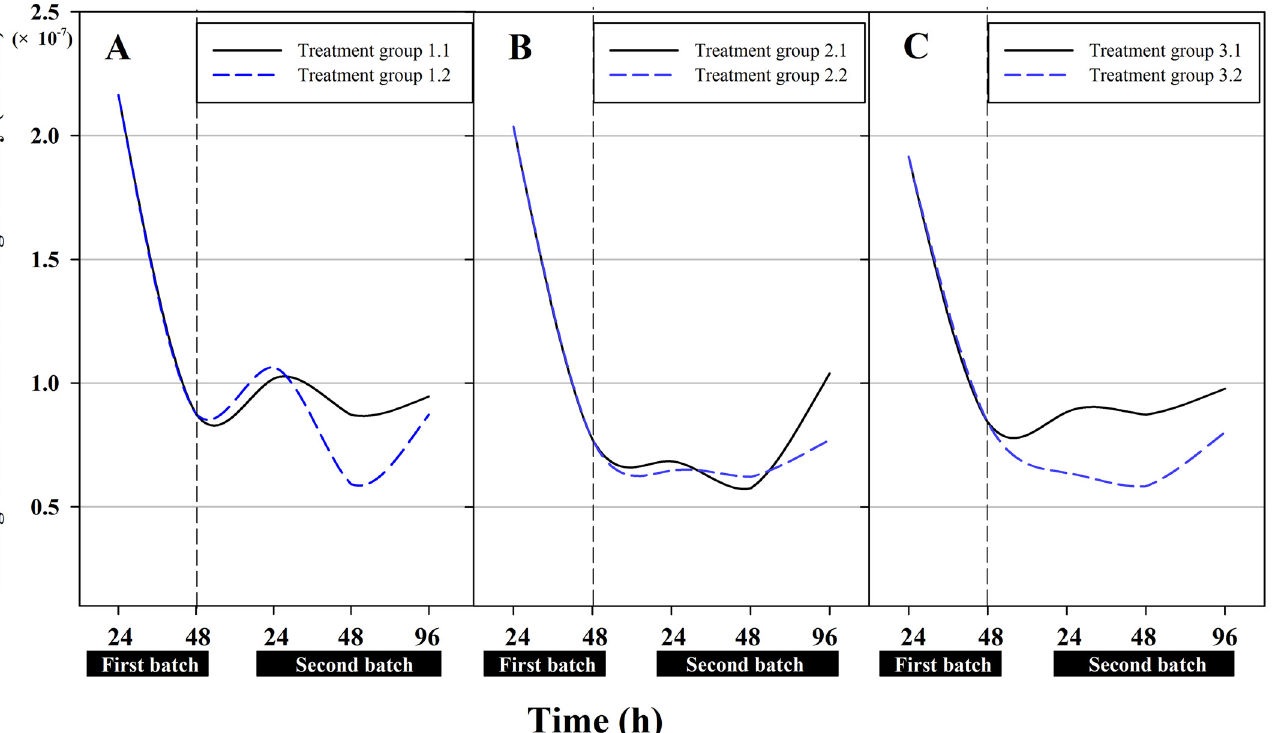
Fig 5. The removal rate of cefradine by a unit algal cell. (A) in Treatment group 1.1 and 1.2. (B) in Treatment group 2.1 and 2.2 (C) in Treatment group 3.1 and 3.2.